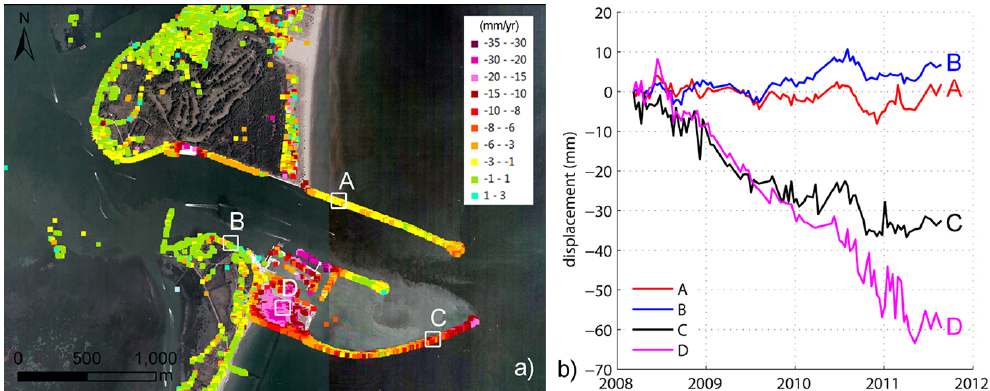
Figure 3. (a) Mean displacement rates between March 2008 and August 2011 from TerraSAR-X interferometry at Malamocco inlet. The image background is an aerophotograph acquired in 2007. Negative values indicate settlement, positive mean uplift. (b) Displacement history in the satellite line-of-sight direction for four scatterers (A, B, C, D). See location 1a in Fig.